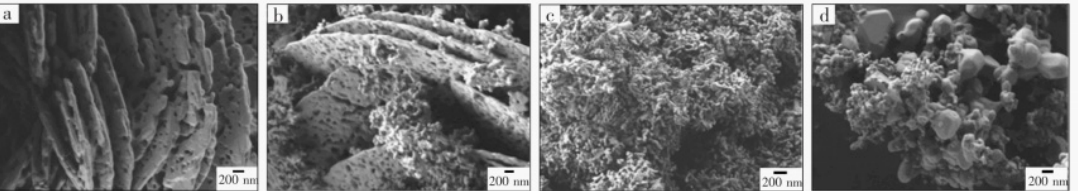
Figure 9. SEM of Cu/Co catalysts with different ratios: ( a ) Cu 0 Cu 5 ; ( b ) Cu 1 Co 8 ; ( c ) Cu 1 Co 4 ; ( d ) Cu 1 Co 2 [172]. Table 6. Non-noble metal oxide catalysts for catalytic oxidation of VOCs.